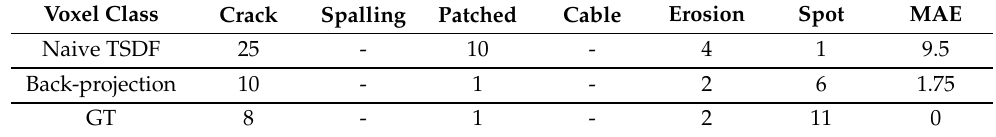
Table 4. Result of 3D IoU instance fusion. We count the instance number of different defect class.